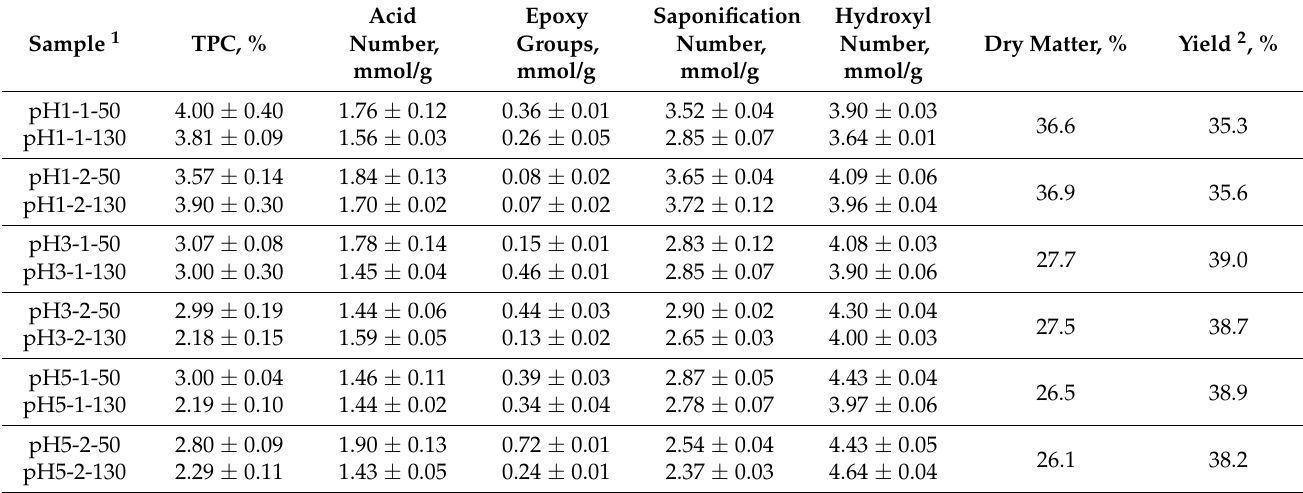
Table 2. Chemical properties of SA